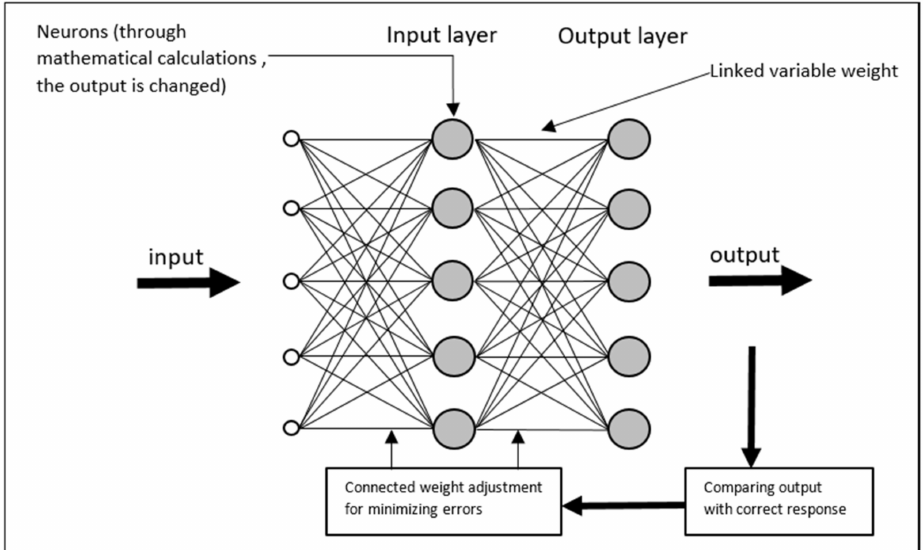
Figure 3. A three-layer neural